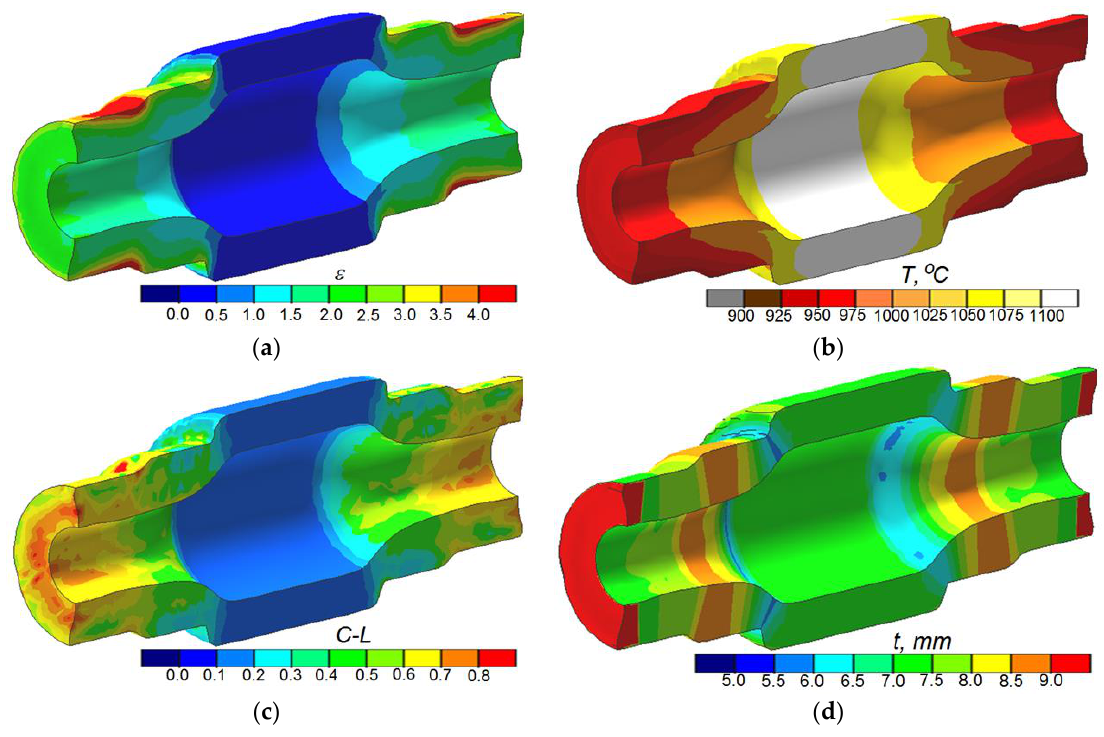
Figure 5. FEM-modeled distributions of: ( a ) effective strain, ( b ) temperature, ( c ) Cockcroft–Latham ductile fracture criterion, ( d ) wall thickness at the end of Operation 1.